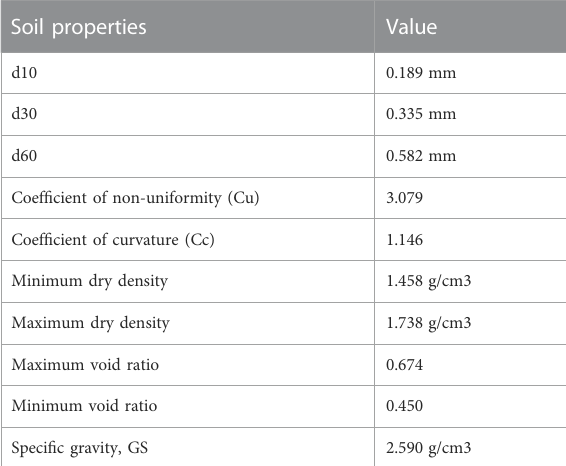
TABLE 1 Physical properties of reclaimed